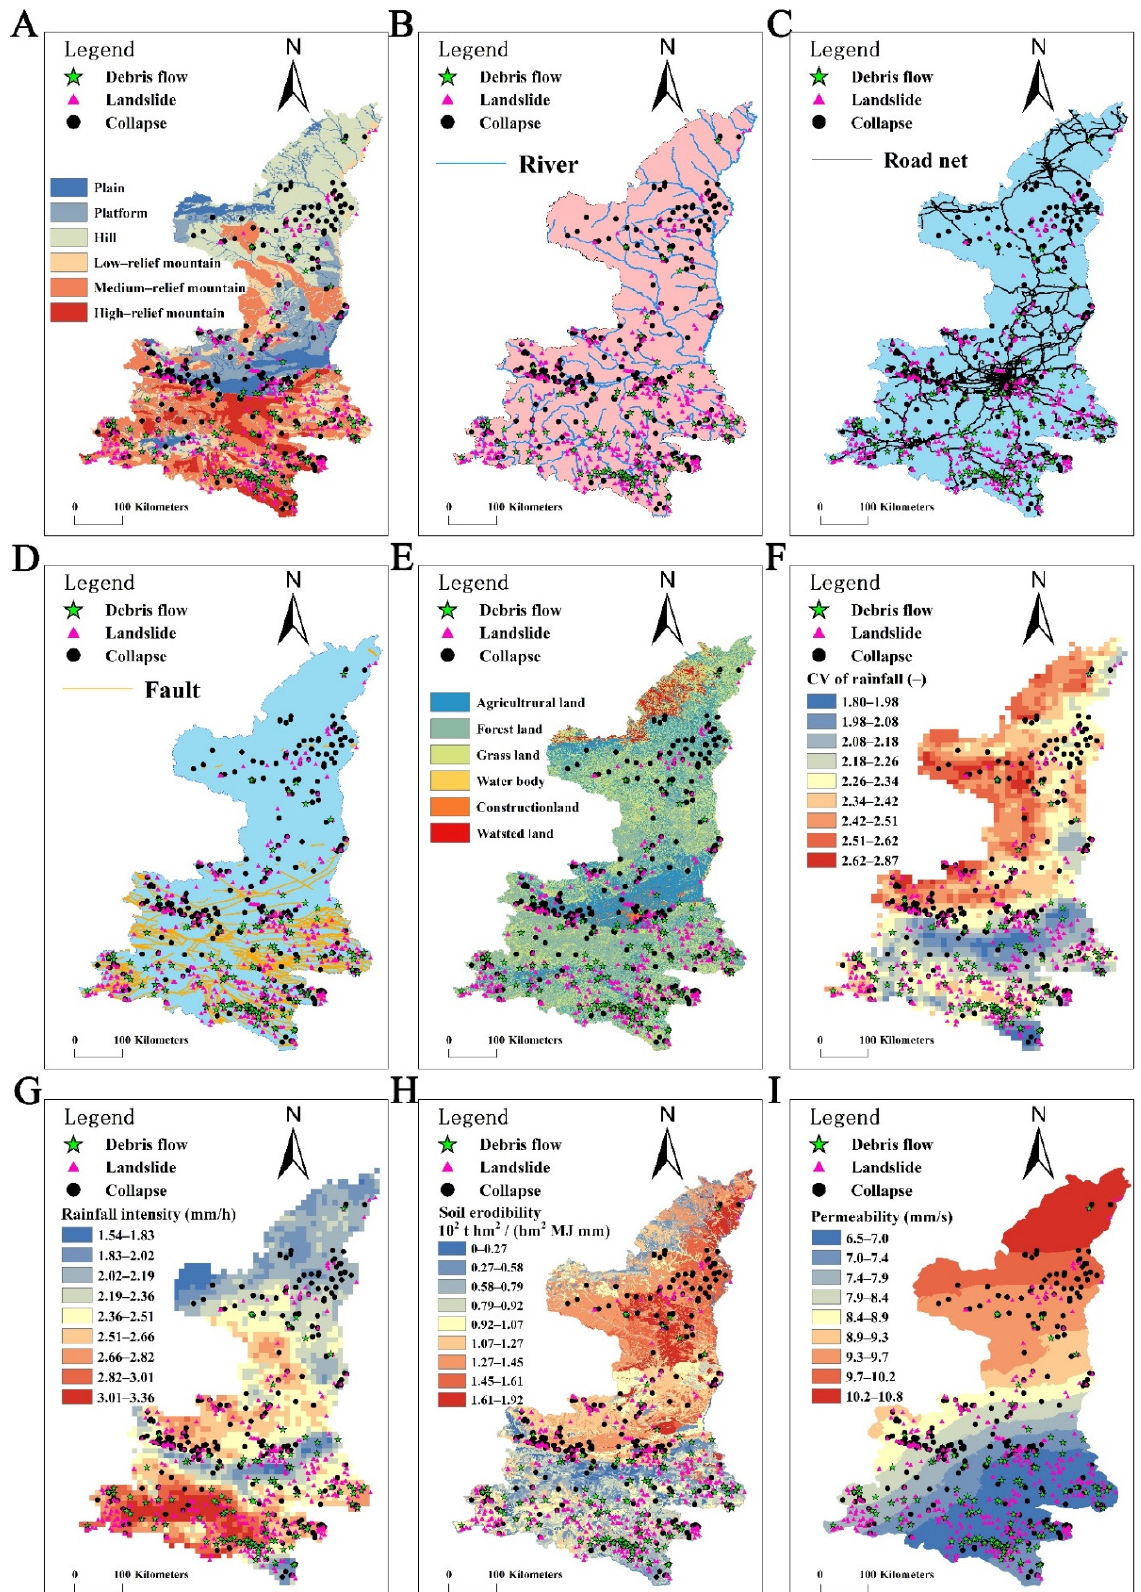
Figure 4. The spatial distribution of potential impact factors (i.e., geomorphic types ( A ), river ( B ), road ( C ), fault ( D ), land use ( E ), CV of rainfall amount ( F ), the maximum 1 h intensity ( G ), soil erodibility ( H ) and permeability coefficient ( I ).